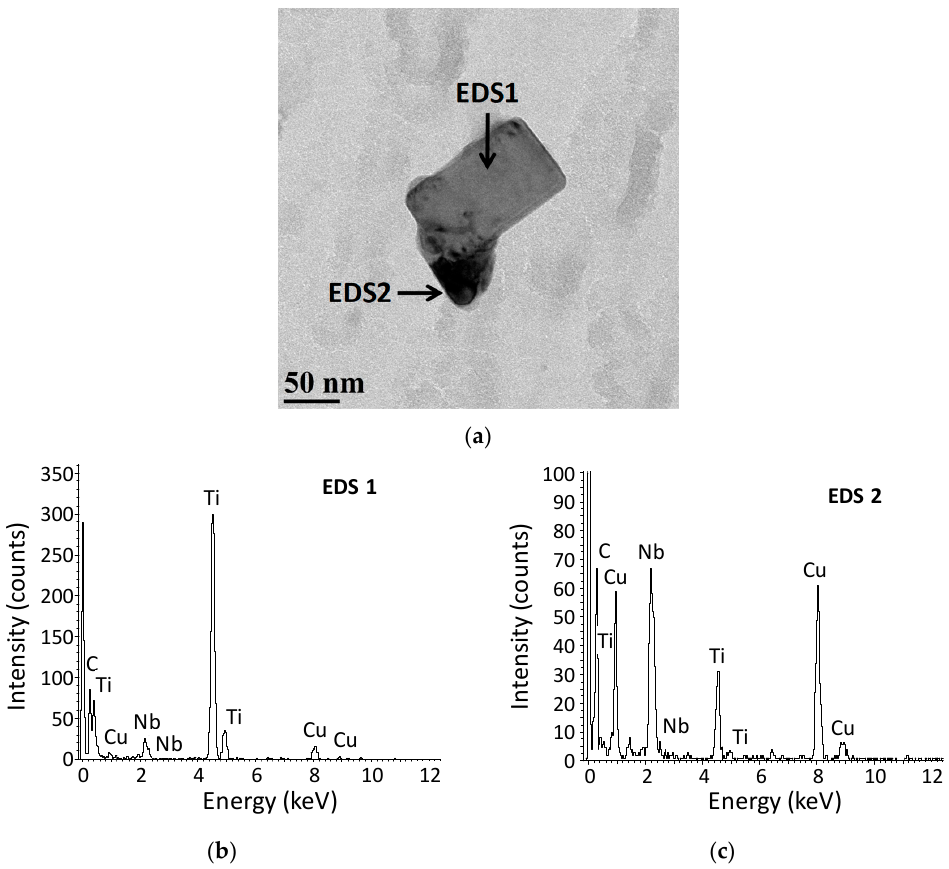
Figure 10. ( a ) Example of Ti-Nb undissolved precipitate with Nb-Ti co-precipitate observed in the Ti5Nb3 900 °C-1000 s sample and, ( b , c ) corresponding EDS analysis .